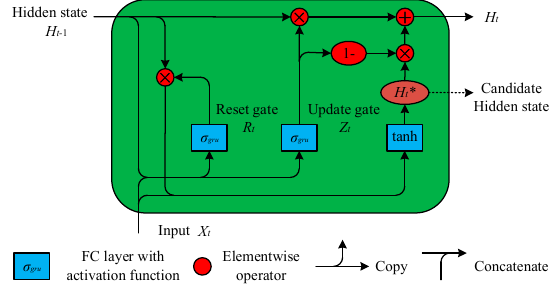
Figure 1. Gated recurrent unit (GRU) structural unit [32].